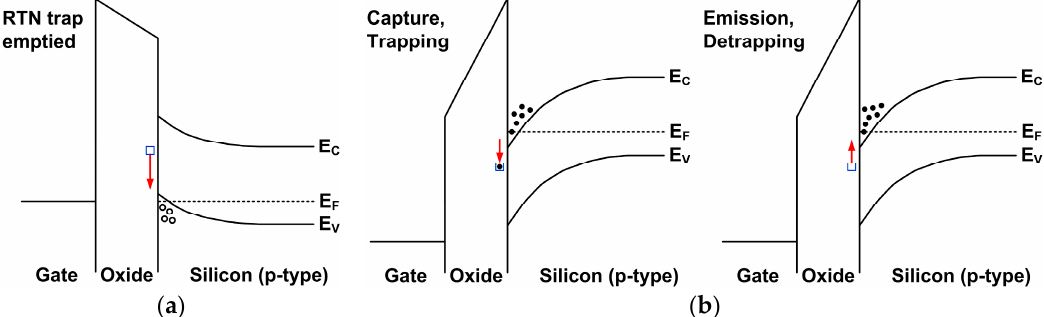
Figure 22. ( a ) Band diagram for a NMOS SF under the accumulation condition when it is turned OFF.